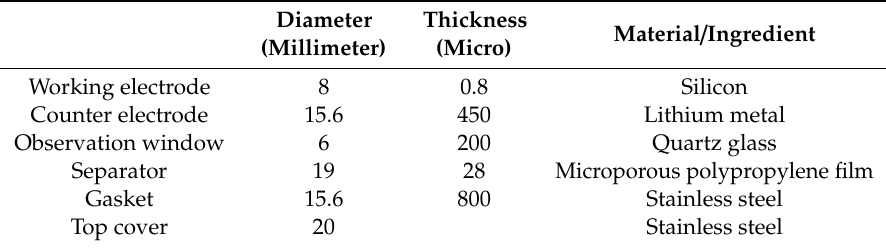
Figure 3. Structural schematics of the button cell in ( a ) common mode and ( b ) reverse mode: 1, copper foil; 2, working electrode (silicon electrode); 3, top cover; 4, separator; 5, counter electrode (lithium metal); 6, gasket; 7, steel jacket. The picture of a well assembled button cell is shown in ( c ) and a microscopic image of the Si electrode in ( d ), and the red box represents the region of interest in ( d ). Table 1. Parameters of the cell